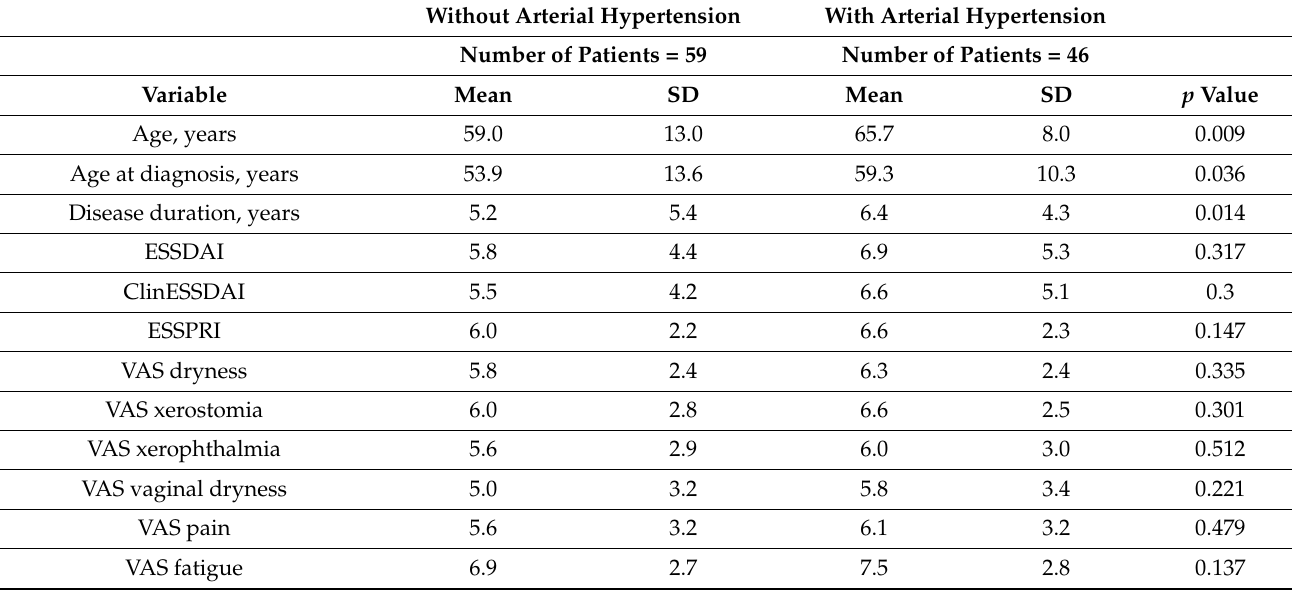
Table 3. Characteristics of the study cohort ( N = 105) according to the presence or absence of arterial hypertension